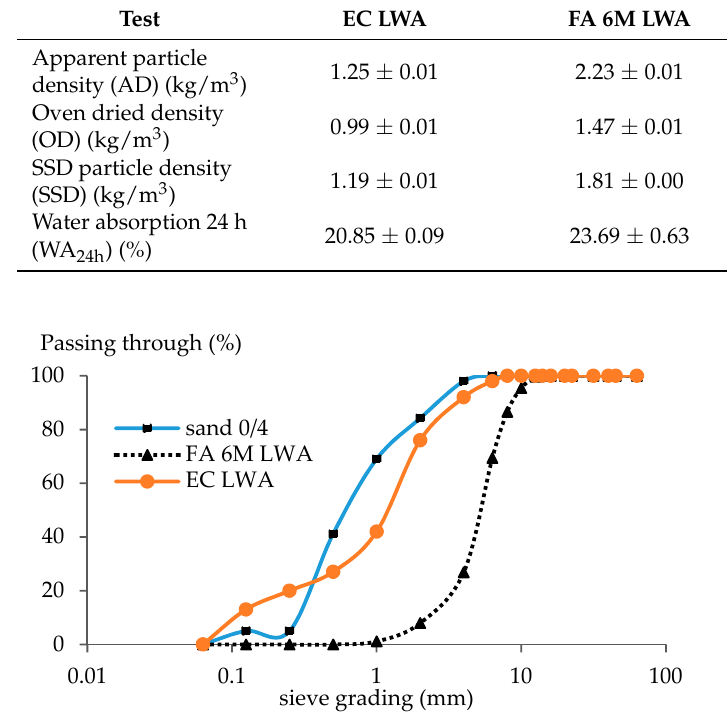
Figure 3. Particle Size Distribution of The Aggregates.